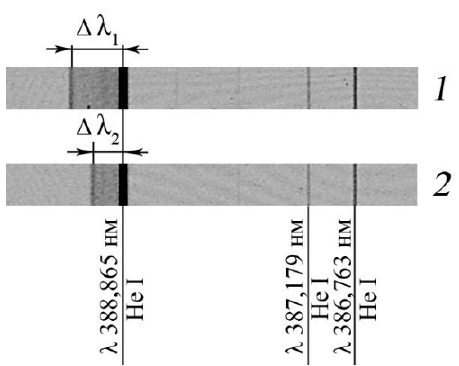
Figure 5. Spectrograms of the discharge plasma at helium pressure p = 0.3 Pa and voltage between the chamber and the grids U = 3 kV (1) and 1 kV (2).